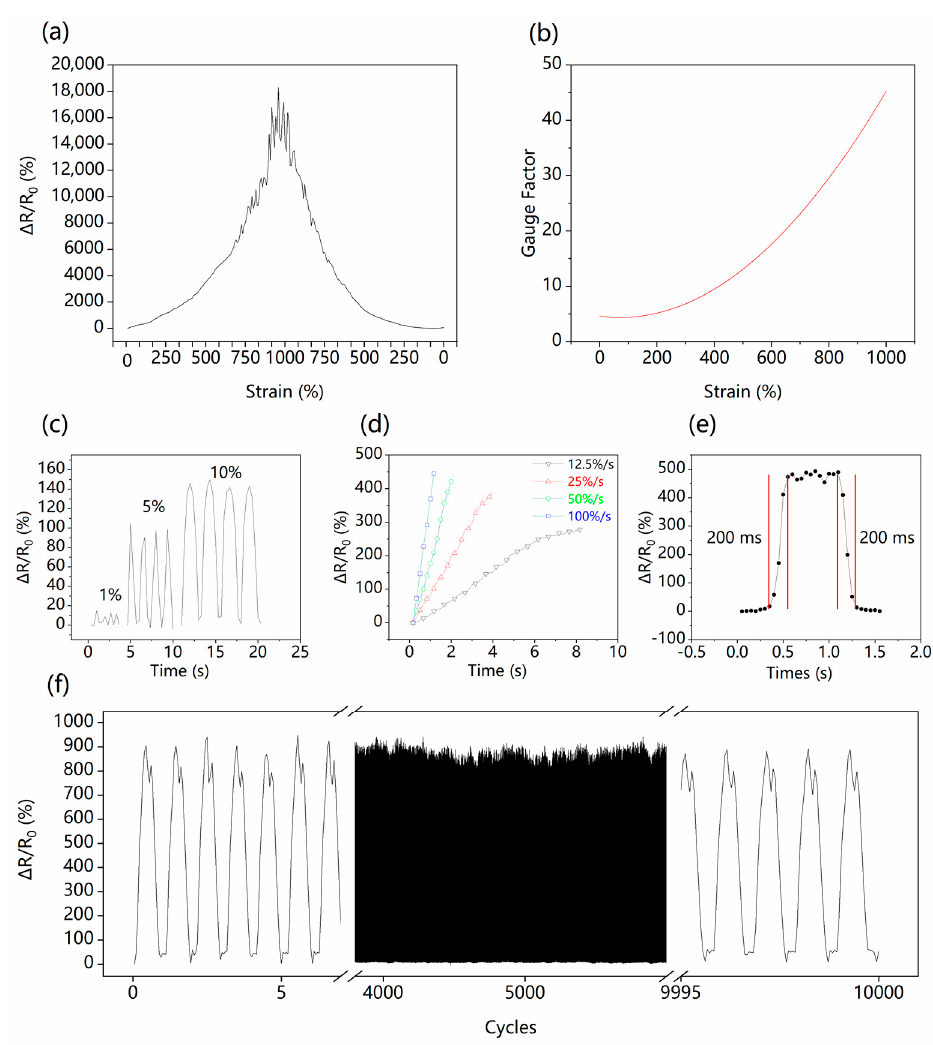
Figure 3. Testing the sensor performance. ( a ) Relative resistance versus strain plot showing stretching to 1000% and releasing, ( b ) gauge factor versus strain from 0–1000%, GFs were calculated by polynomial fitting; ( c ) reversible response of the sensor under small strains from 1% to 10%, ( d ) variation of the resistance of the sensor from 0–100% strain at different strain, ( e ) response/relaxation time of the sensor at a strain of 100%, both of which are 200 ms, ( f ) resistance response of the strain sensor over 10,000 stretch-and-release cycles from 0–200% strain.